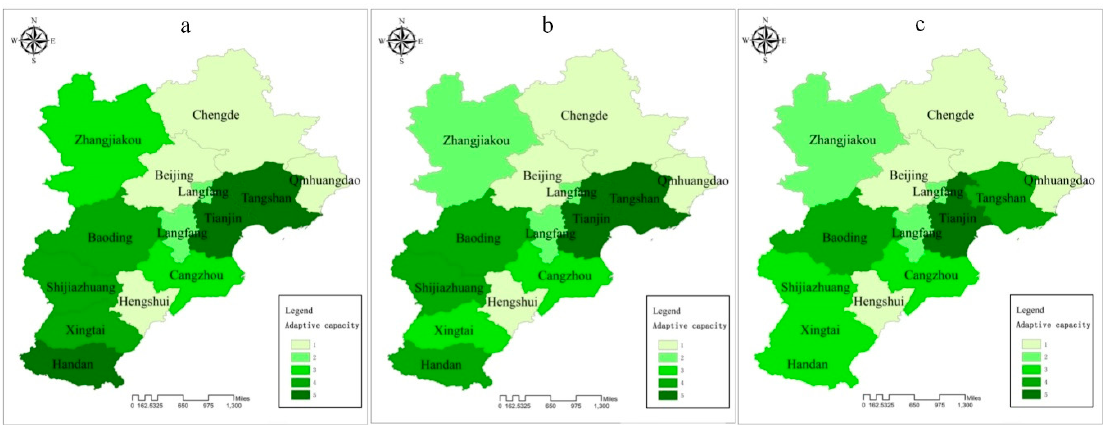
Figure 5. Individual assessment indices of adaptive capacity: ( a ) 2013; ( b ) 2014; ( c ) 2015.